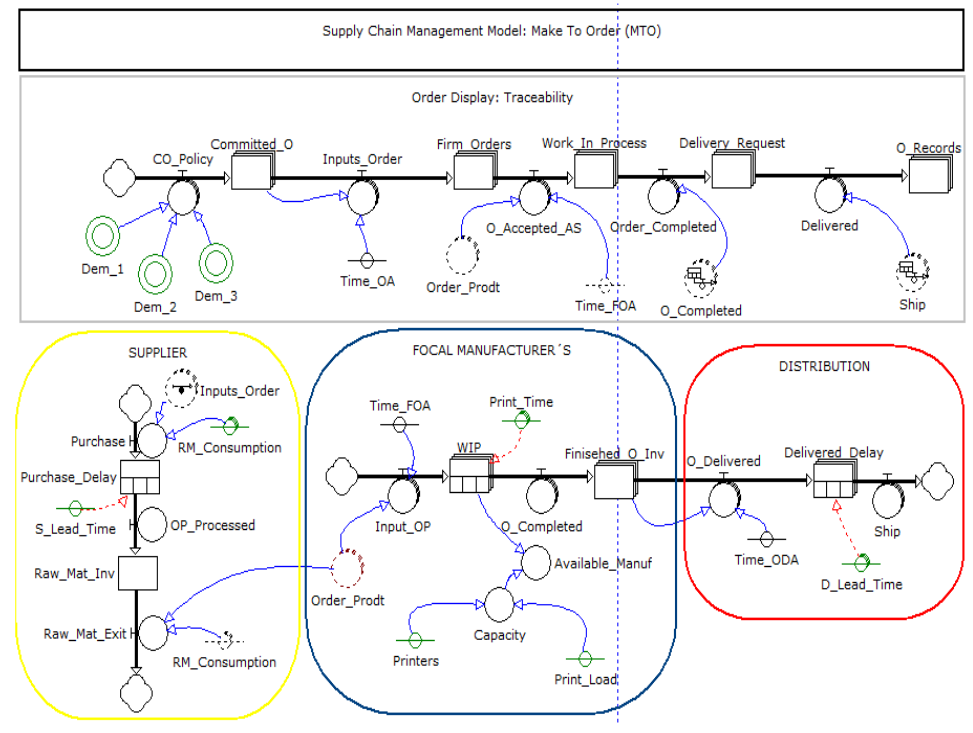
Figure 3. Flow and level diagram. Supply chain model, based on orders (MTO). Reprinted with permission from Nuñez-Rodriguez, et al. [1]; published by Processes, 2021.